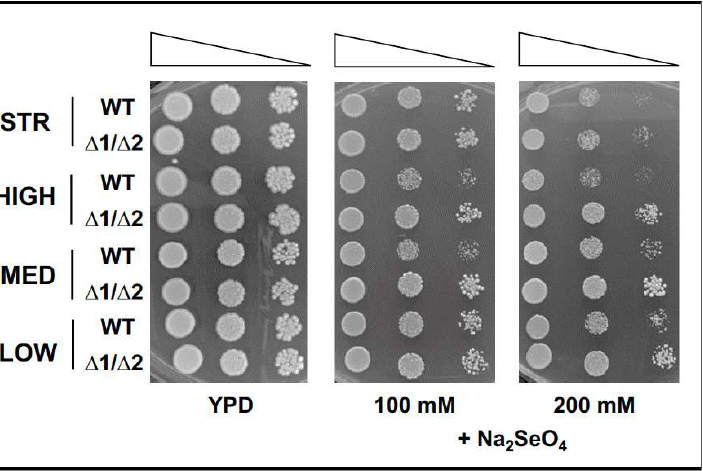
Figure 3. Yeast strains sensitivity to toxic SO 4-- -analogues. As in Figure 1, yeast growth of parental (WT) and double mutants ∆ SUL1 / ∆ SUL2 ( ∆ 1 / ∆ 2 ) of the indicated strains (STR, HIGH, MED, and LOW) was assayed in the presence of increasing concentrations of NaSeO 4 (100 and 200 mM, middle and right panels), and in standard YPD medium as the control (left panel). Images are representative of three independent experiments.